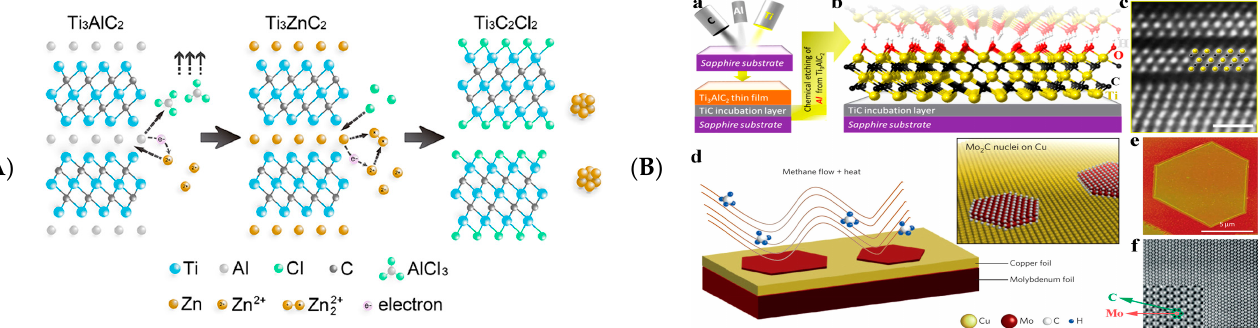
Figure 3. ( A ) Preparation mechanism of Ti 3 C 2 Cl 2 etched by ZnCl 2 . Reprinted with permission from Ref. [30]. Copyright 2019, American Chemical Society. ( B ) Bottom − up approach to obtain MXenes. Atomic layer deposition method: steps to prepare Ti 3 AlC 2 MAX films by sputtering Ti, Al and C on a sapphire substrate (a), schematic diagram of Ti 3 C 2 T x (b) and STEM images (c). CVD method: schematic diagram of the Mo 2 C synthesis process (d), AFM images of hexagonal ultra − thin Mo 2 C crystals (e) and STEM images (f). Reprinted with permission from Ref. [27]. Copyright 2020, American Chemical Society.